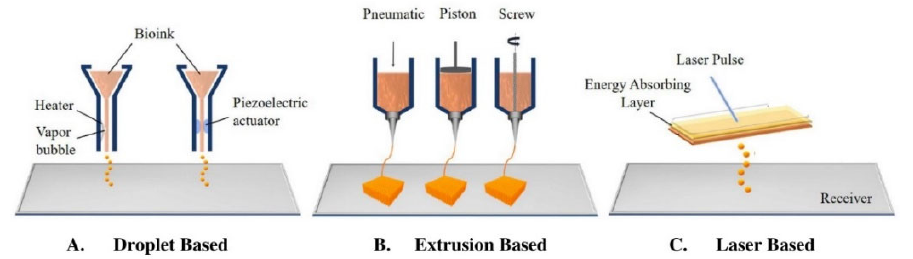
Figure 2. The three types of bioprinting: ( A ) Droplet-based, ( B ) Extrusion-based, and ( C ) Laser-based. Figure is adapted from Tamay et al., 2019 [81].